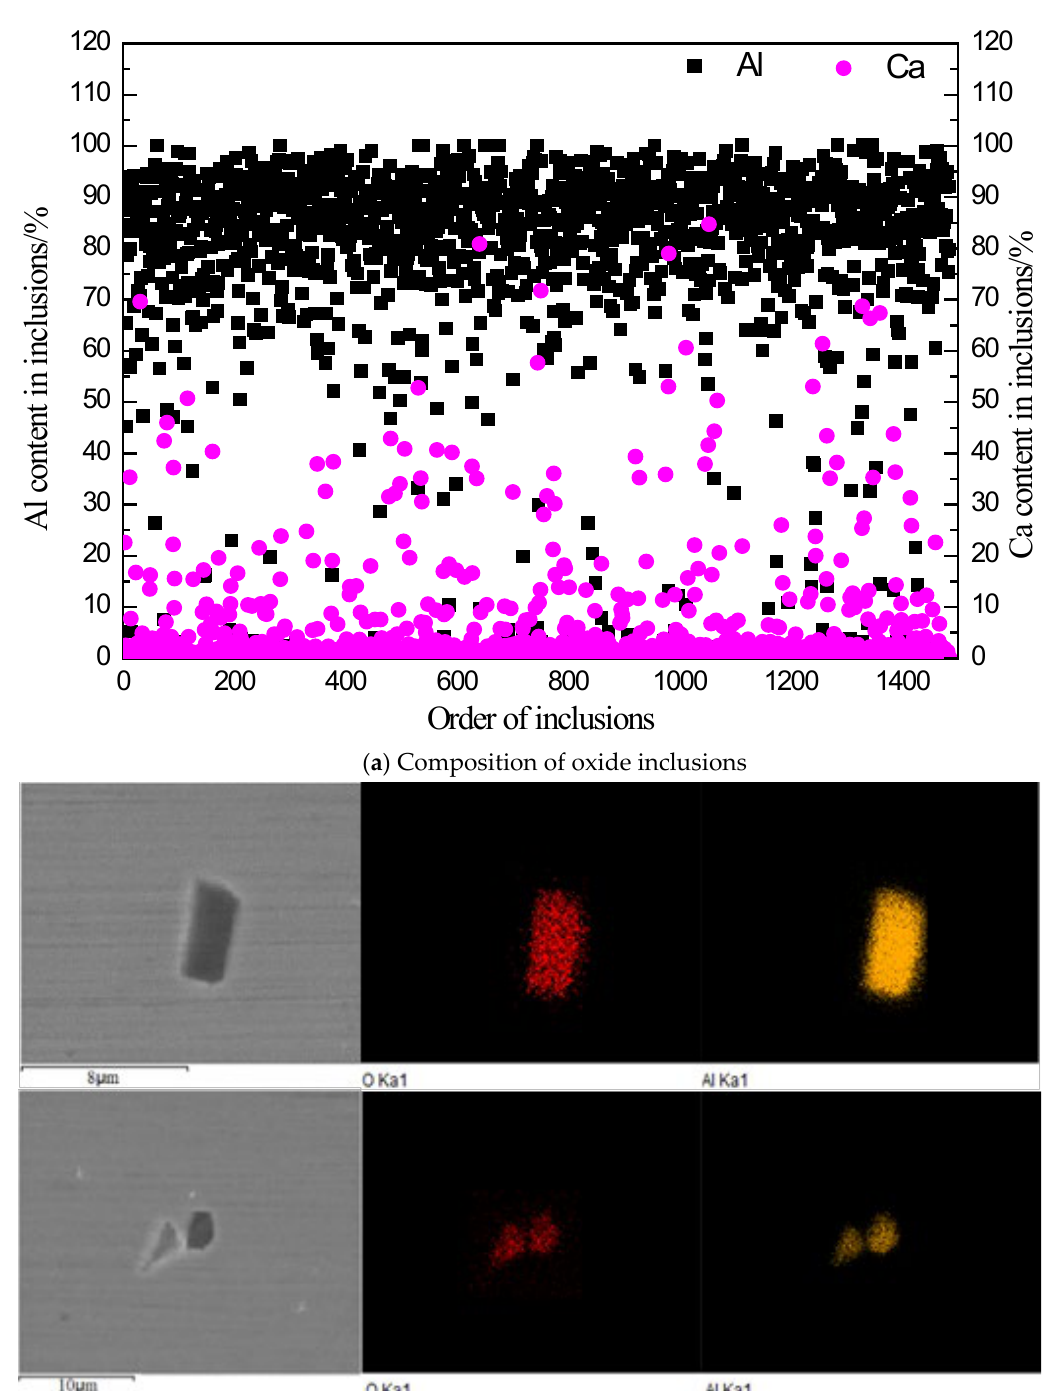
Figure 9. Inclusions in electroslag ingots prepared by 30 wt%Al 2 O 3 -70 wt%CaF 2 slag.